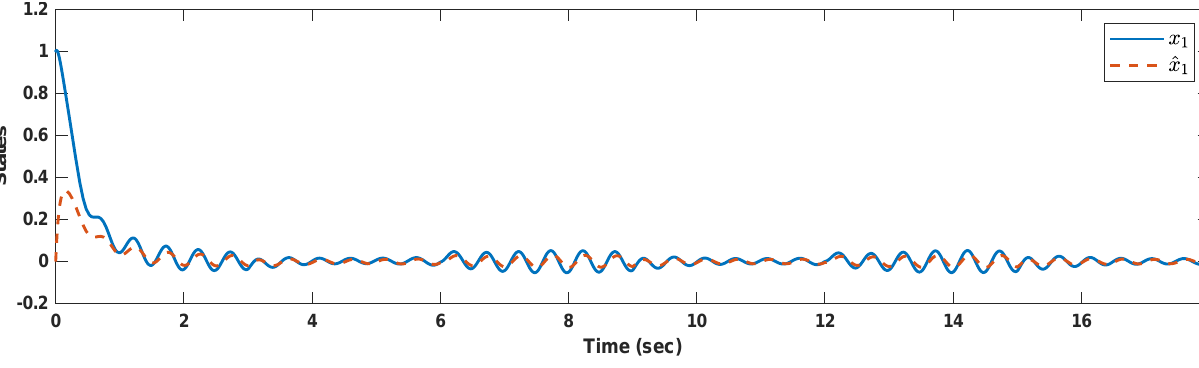
Figure 2. Example 1: First state variable and its corresponding estimation.